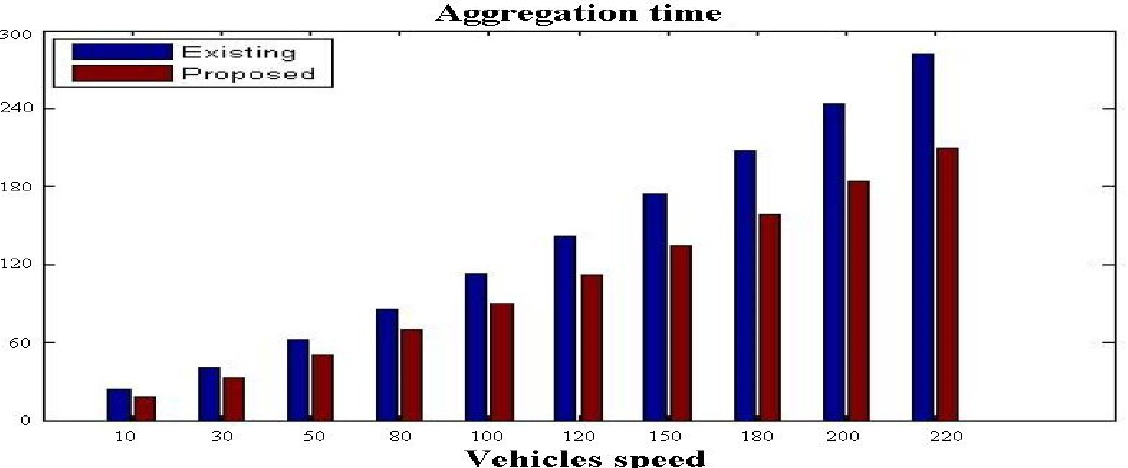
Figure 7. Aggregation time (seconds).